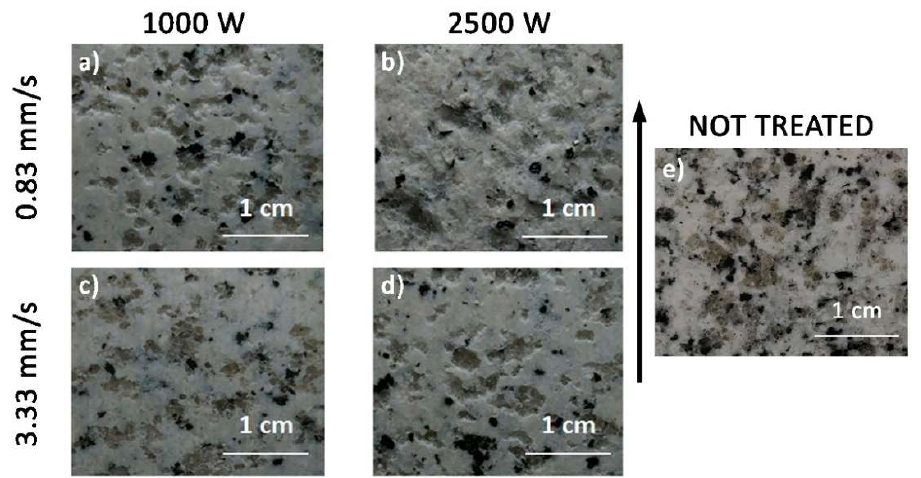
Figure 2. Images showing the aspect of the treated white granite as a function of the laser power and the transverse speed ( a – d ). The black arrow indicates the direction of the “fast” scan speed. ( e ) Image of not treated granite surface.